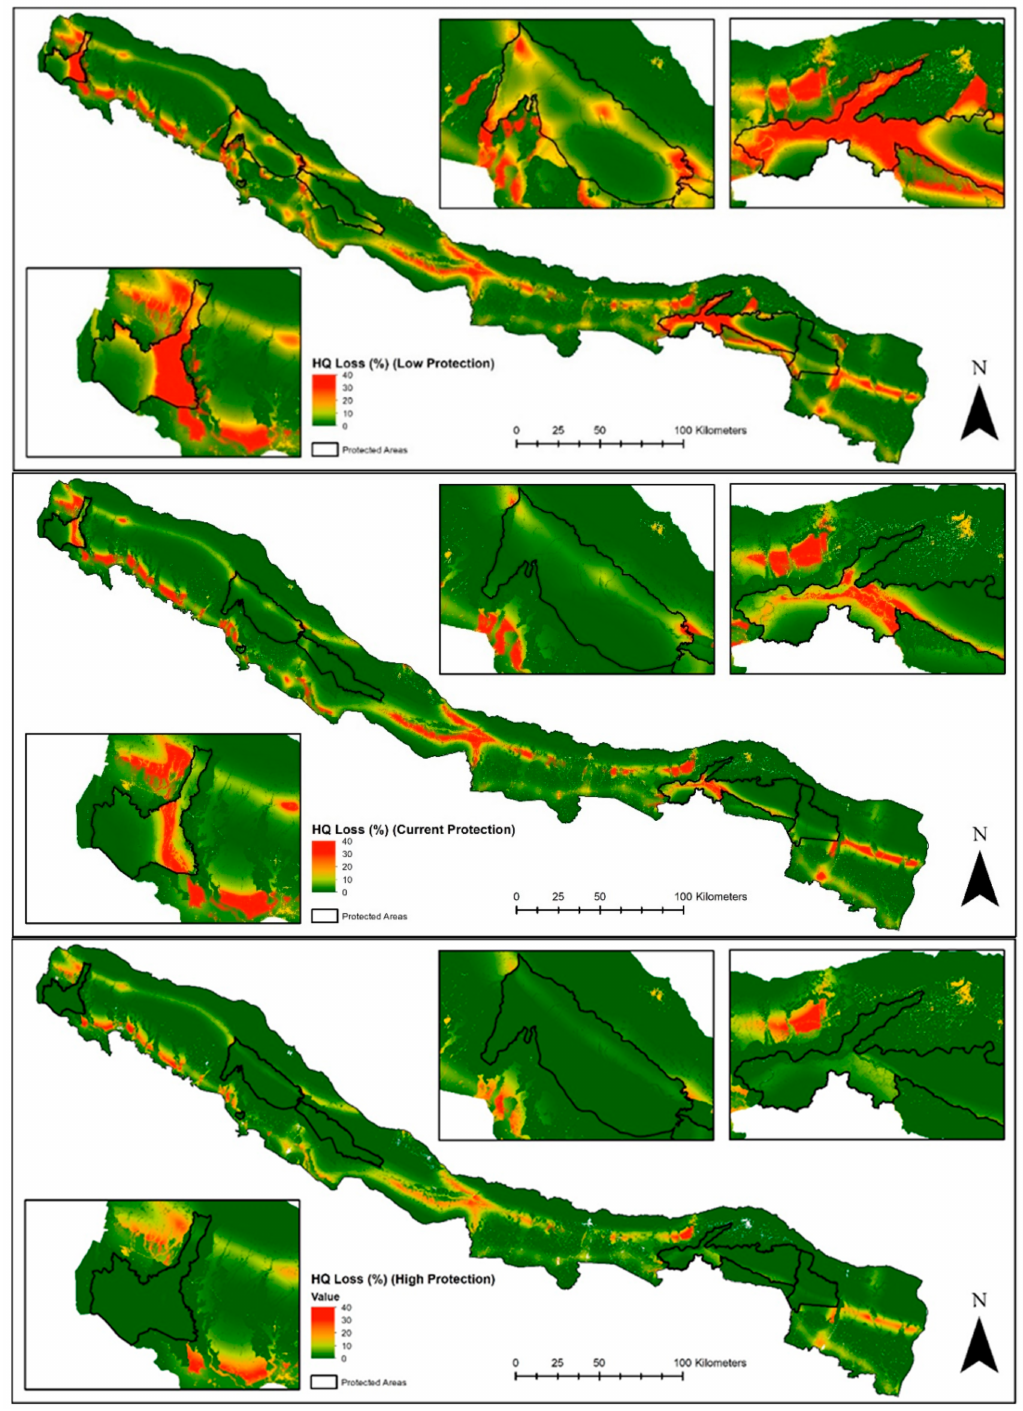
Figure 5. Habitat quality (HQ) loss (in percent) for three protection level scenarios (low protection, current protection, and high protection) with insets for three areas that are precited to be most affected by new infrastructure